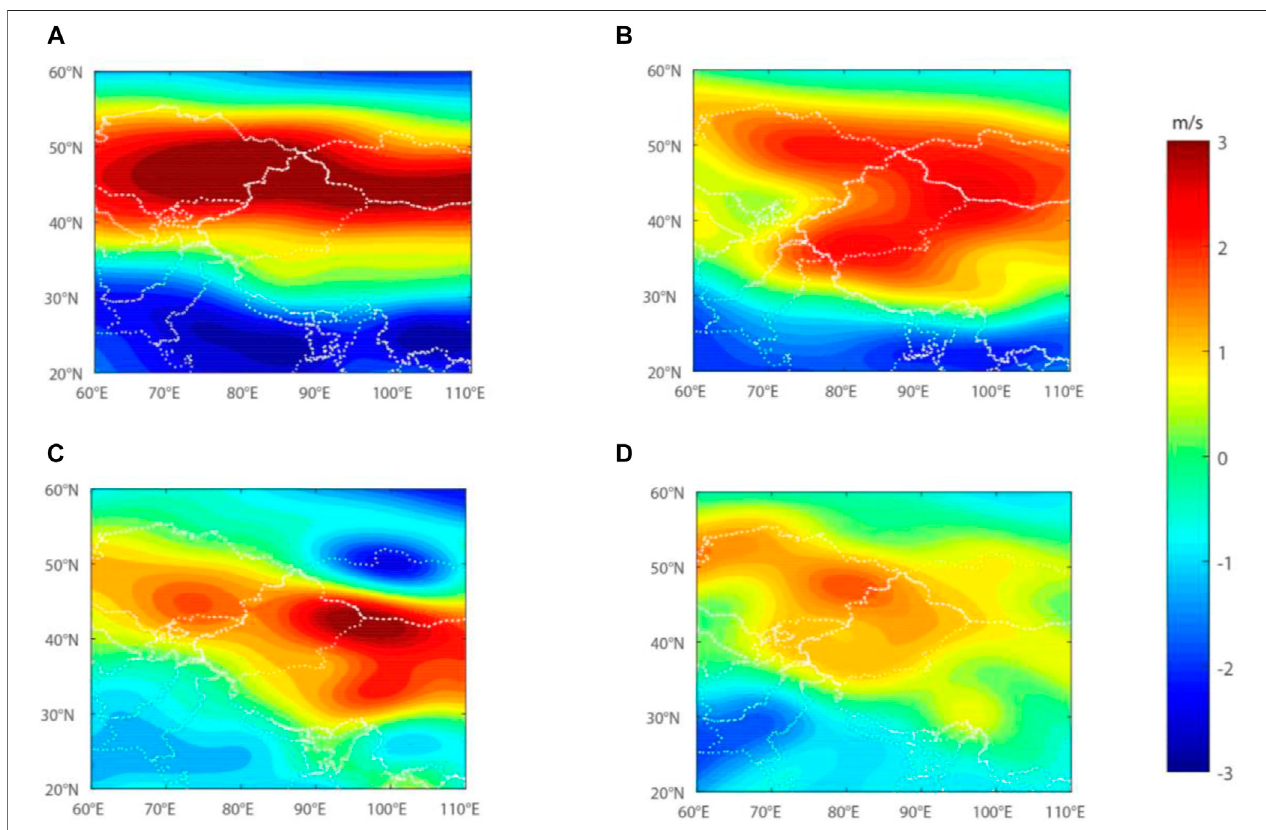
FIGURE 11 | Difference of zonal wind speed between rising period 1960 – 1980 (A,C) , 2000 – 2015 (B,D) and declining period (1981 – 1999) for 500 hPa (A,B) and 200 hPa (C,D) .